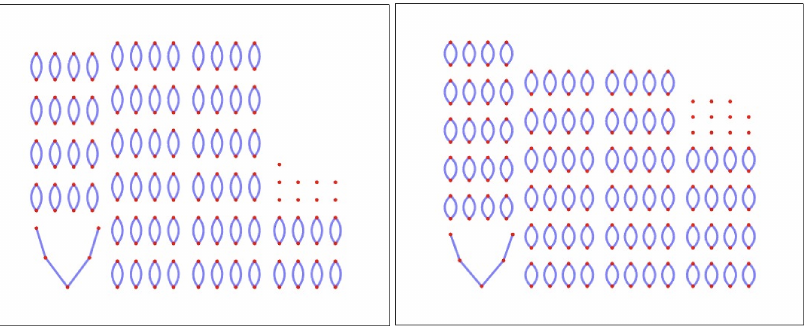
Figure 6. Cycles and paths in meander graphs induced by compositions of type T 0 of 158 and 184.